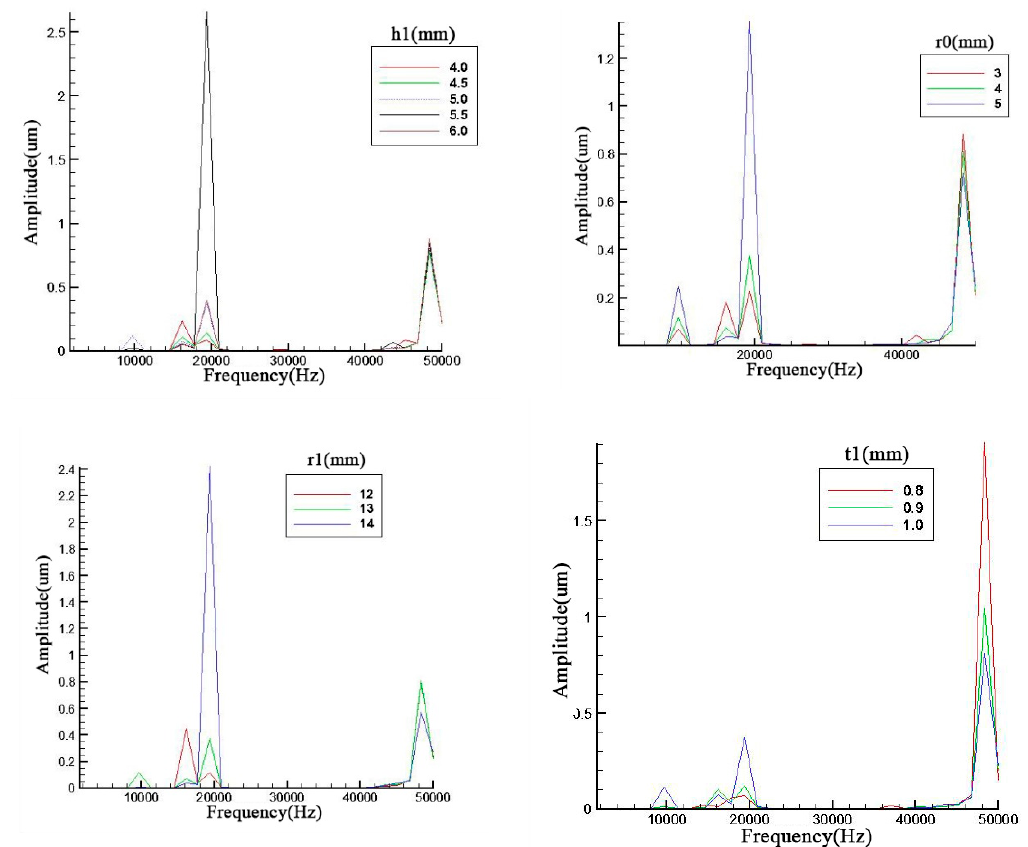
Figure 4. Parameter analysis of h1 , r0 , r1 , and t1 .